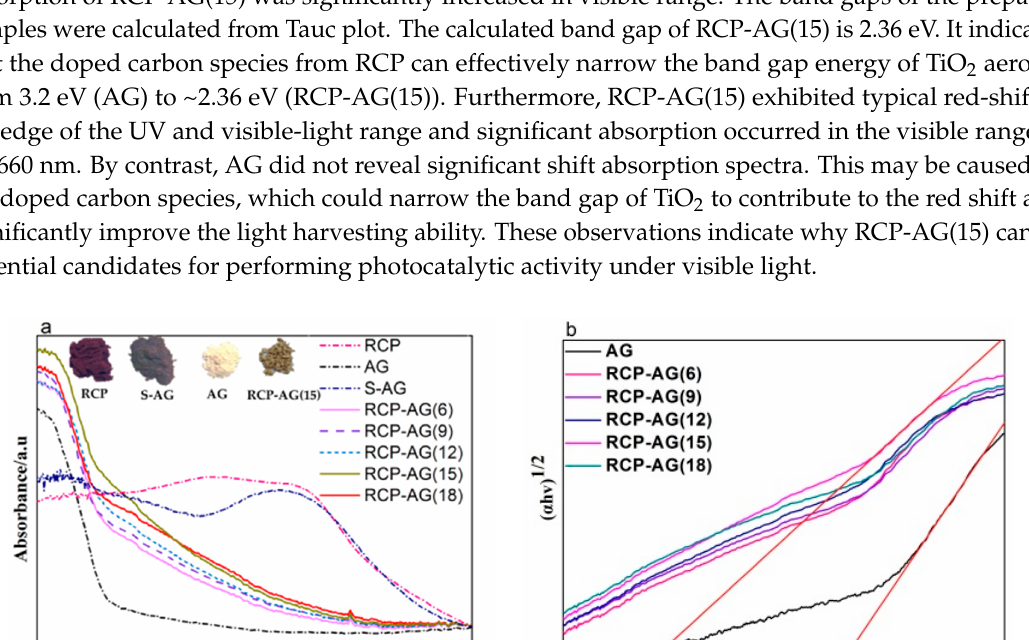
Figure 6. XPS survey spectra of RCP-AG(15) ( a ) C 1s, ( b ) O 1s, ( c ) Ti 2p; XPS survey spectra of AG, and RCP-AG(15) ( d ) Ti 2p.